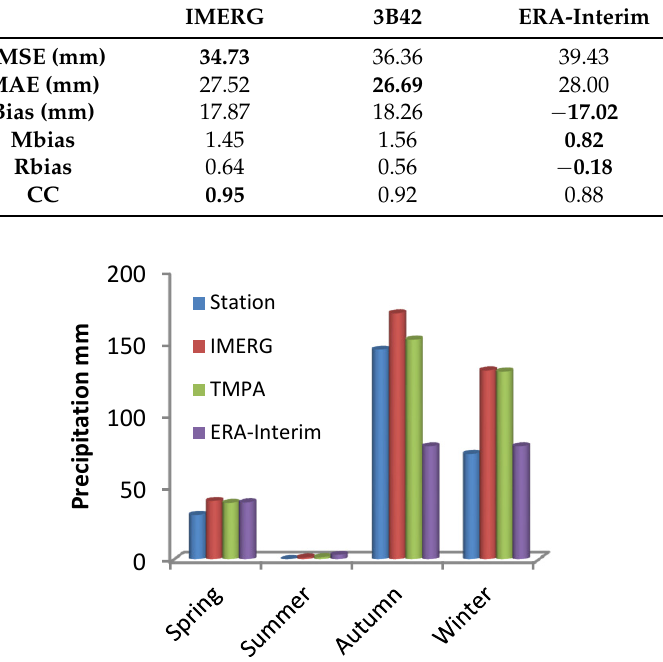
Table 14. Statistical indices of seasonal precipitation in Kermanshah area.